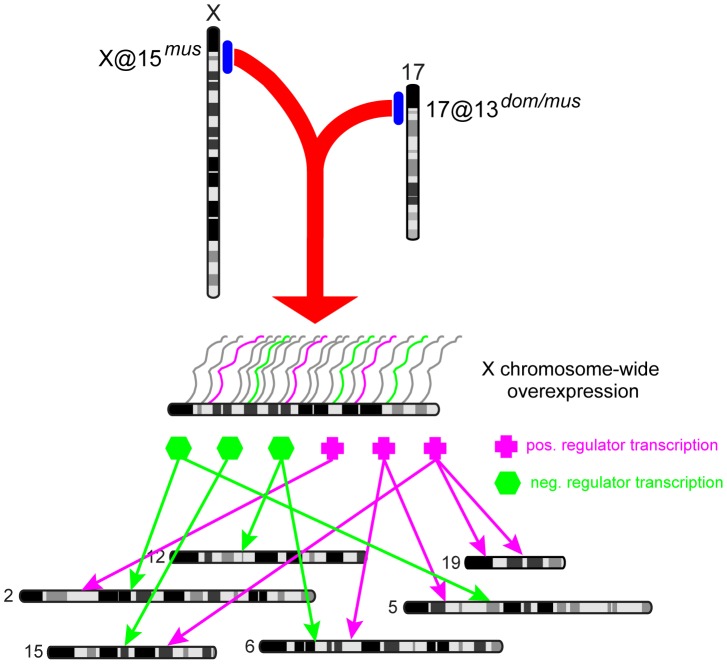
Model of genome-wide expression effects caused by X-17 interaction.A musculus
PWD allele on the X @15 cM interacts with heterozygous 17@13 cM (likely Prdm9) to cause overexpression of the X chromosome during meiosis. X-linked transcriptional regulation genes, which are usually silenced by MSCI, affect expression of autosomal genes.